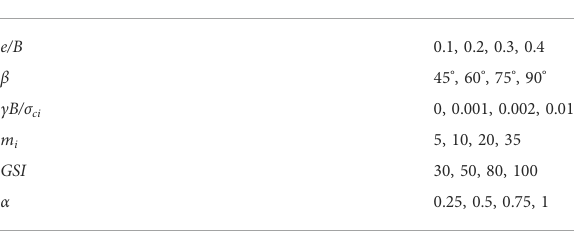
TABLE 1 List of parametric values used for modelling the load on footing and Hoek-Brown material.